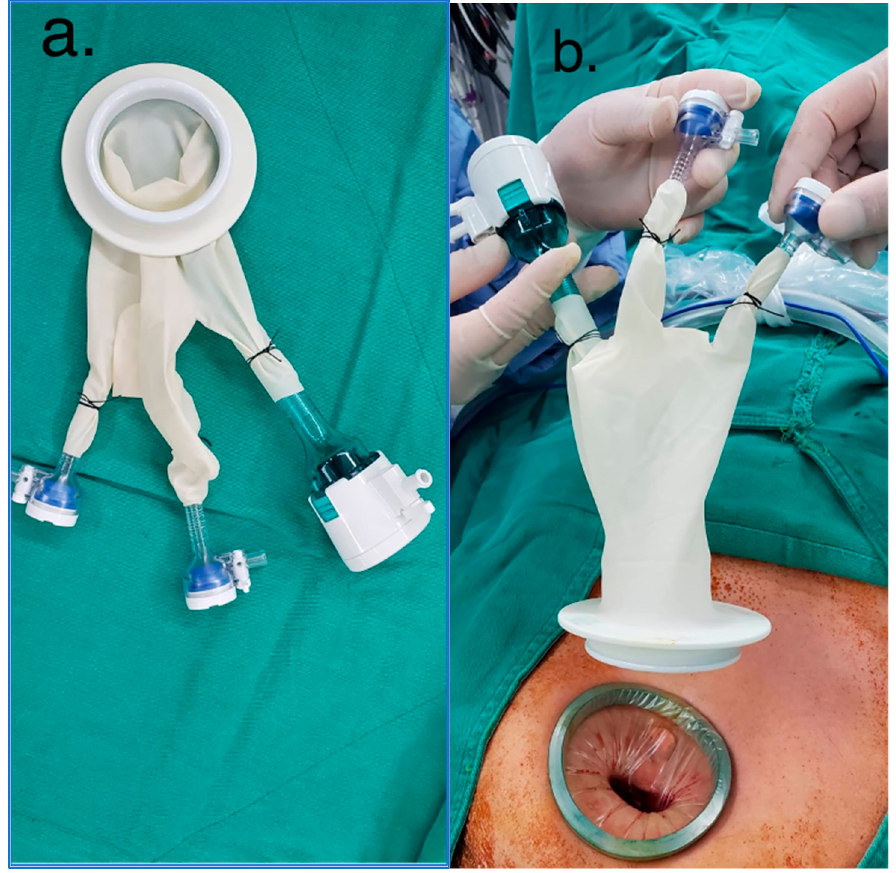
Figure 2. The homemade glove access and the wound retractor. ( a ) The homemade glove access was obtained using an 11 mm trocar and two 5 mm trocars; ( b ) The homemade glove access and the wound retractor (LAGIS ® WR-60ES) (before being attached).